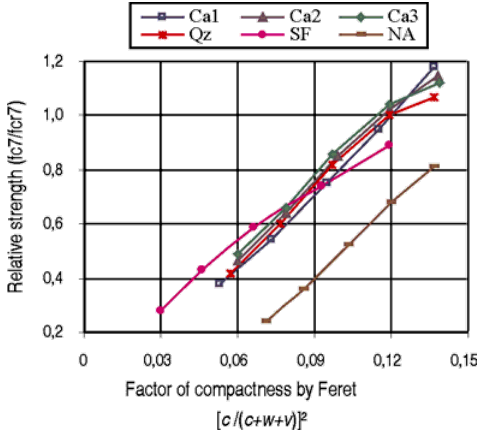
Fig 6. Evaluation of the relative compressive strength in 7 days according to the compactness factor [( c /( c + w + v )] 2